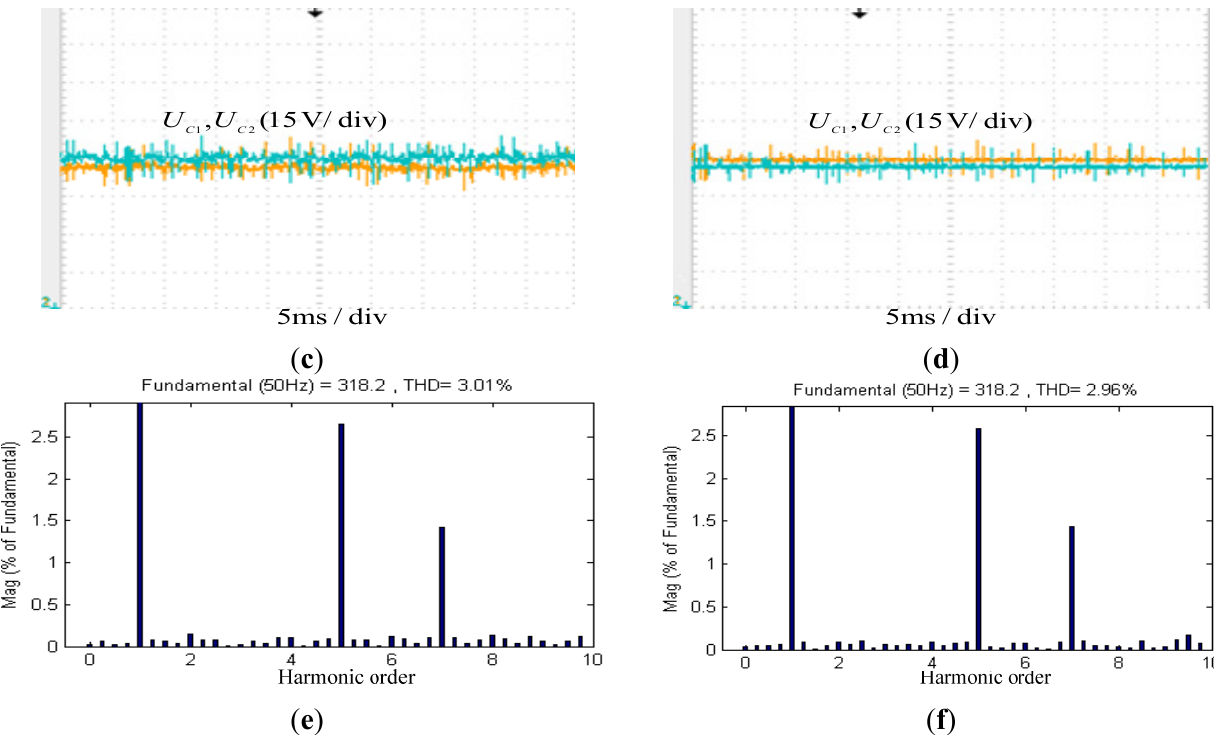
Figure 7. Experimental results of VSVM and VVSVM; ( a ) the line to line voltage and the load current in VSVM; ( b ) the line to line voltage and the load current in VVSVM; ( c ) balanced steady state of U C1 and U C2 in VSVM; ( d ) balanced steady state of U C1 and U C2 in VVSVM; ( e ) FFT (Fast Fourier Transformation) analysis of line-to-line voltage in VSVM; ( f ) FFT analysis of line-to-line voltage in